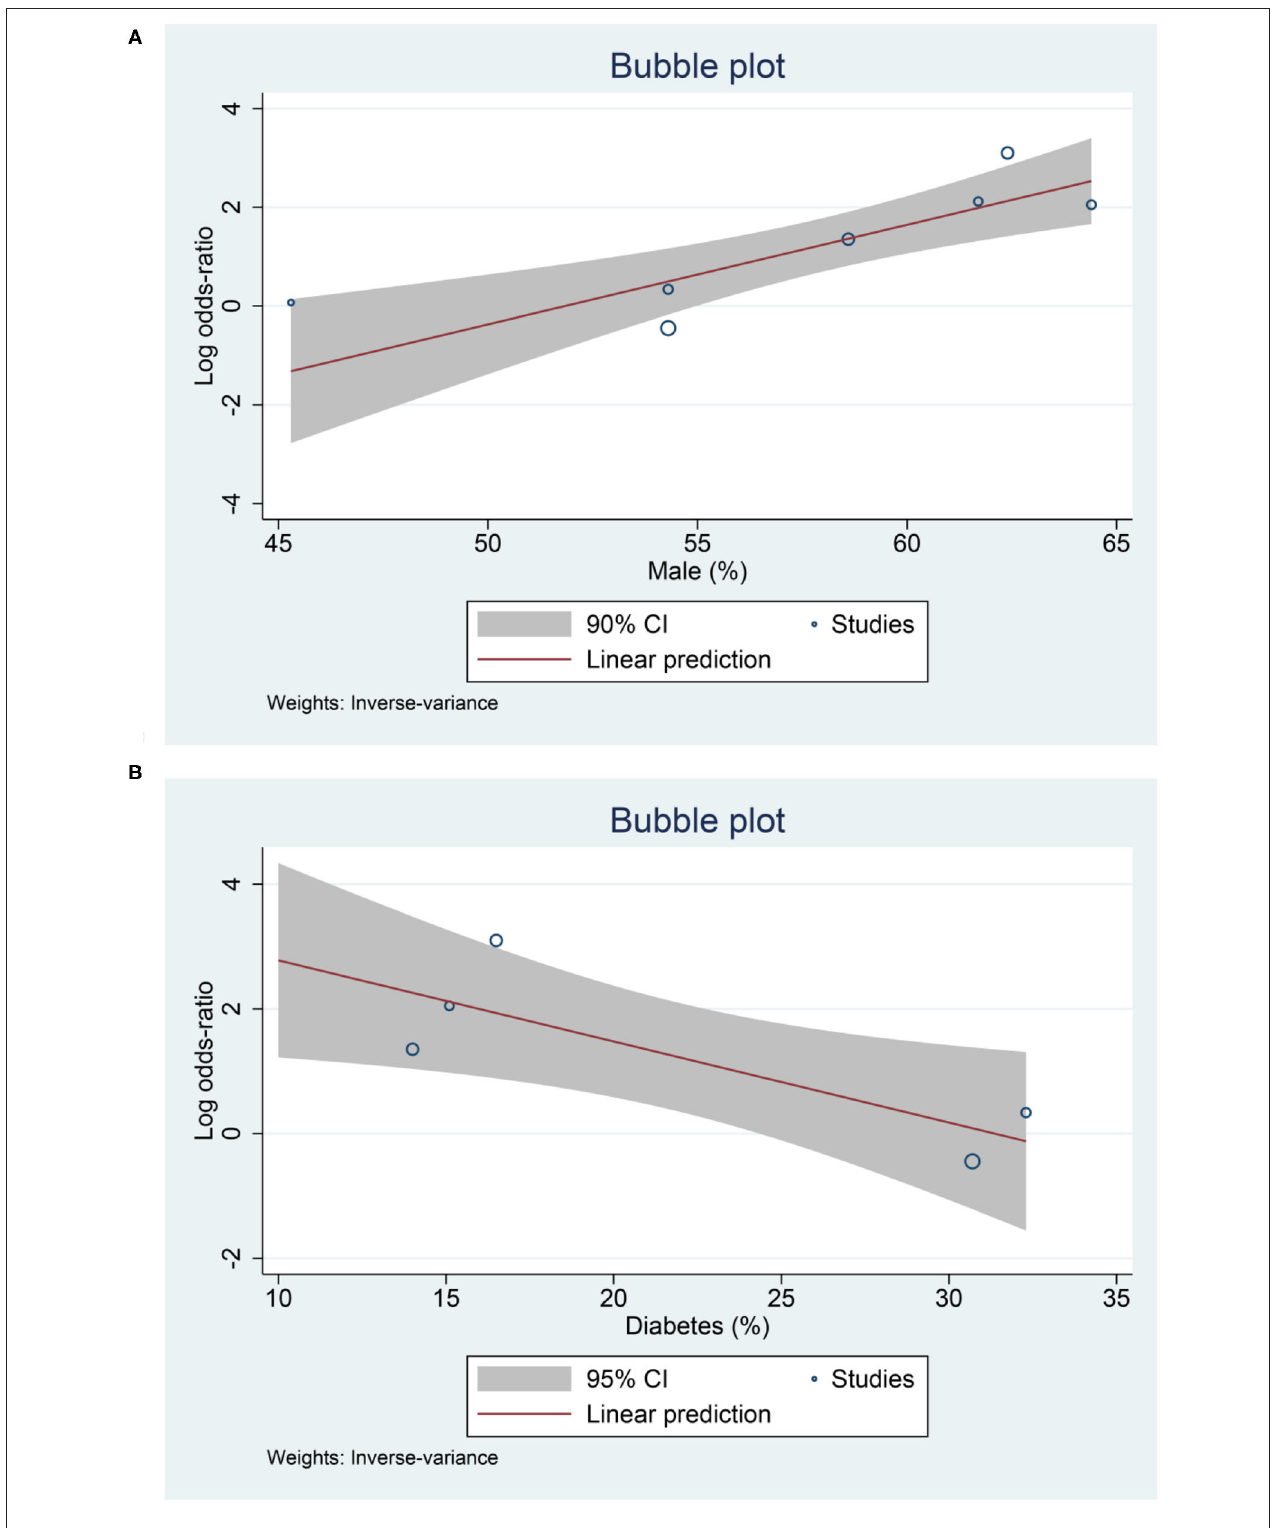
FIGURE 5 | Meta-regression Analysis. Male (A) and diabetes (B) .